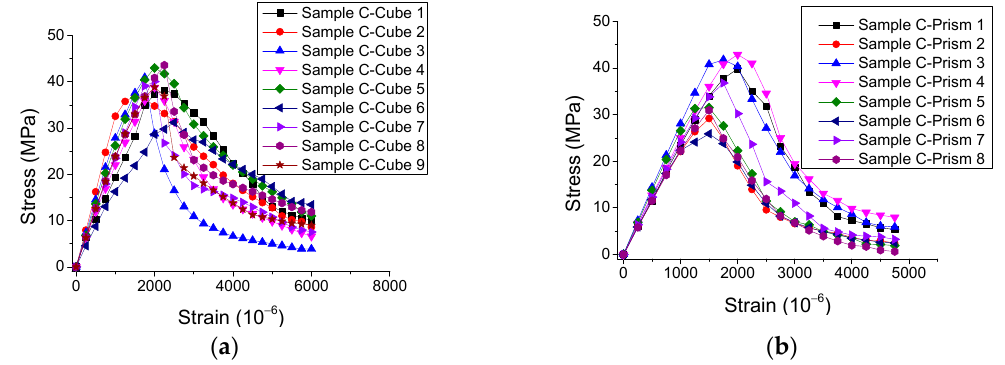
Figure 2. Experimental results of stress-strain curves for SCC prismatic specimens under monotonic direct tension.